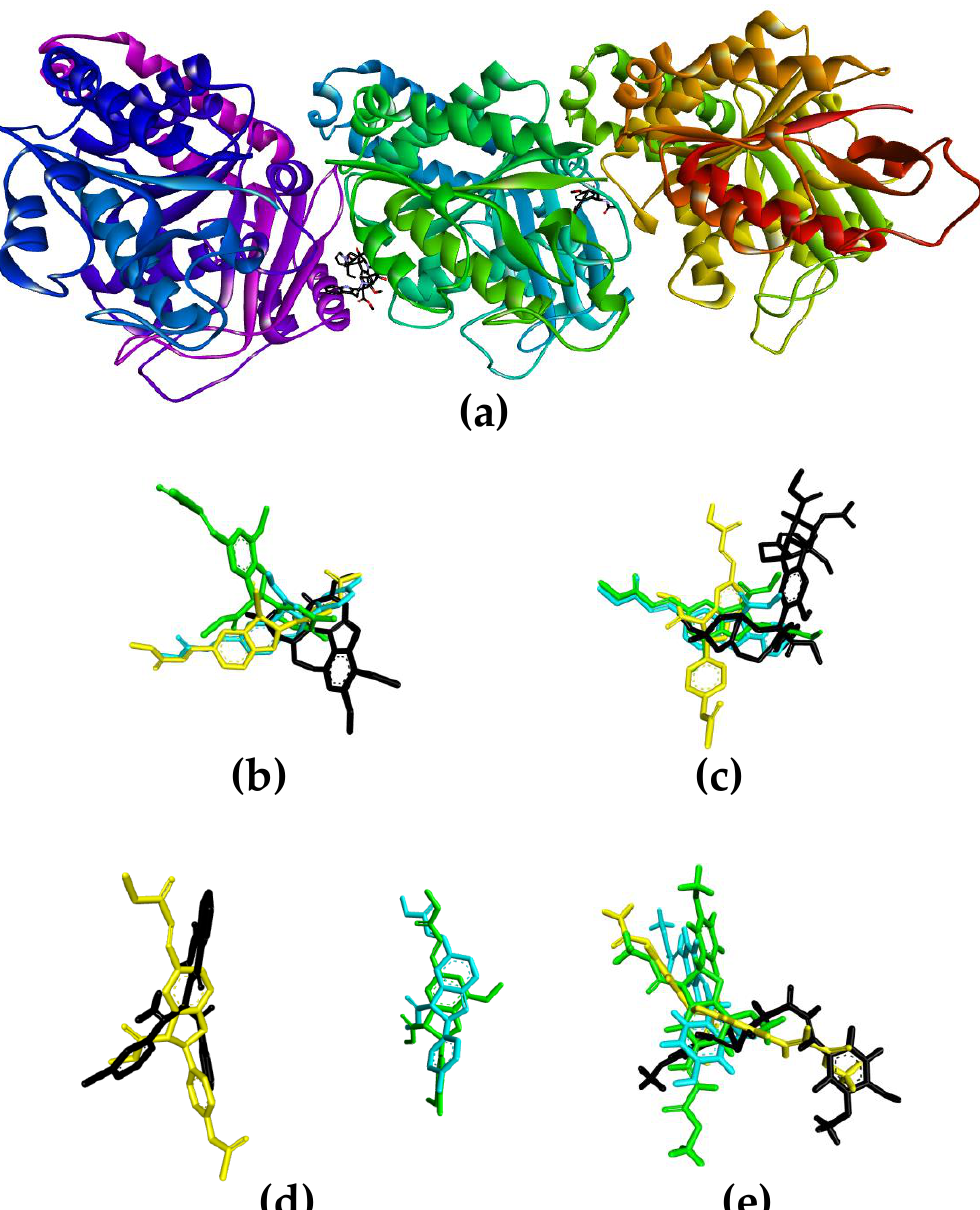
Figure 1. ( a ) α - β - α -tubulin structure, built by homology modeling. Overlays of DBNs 1 (blue), 2 (green), and 4 (yellow) with colchicine ( b ), vinblastine ( c ), imido-1,4-naphthoquinone derivative ( d ), and curcumin ( e ).